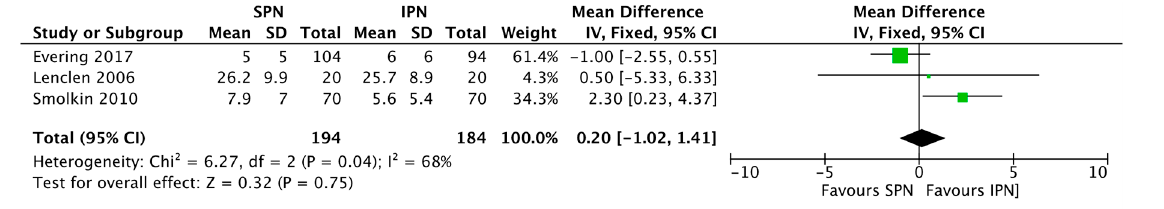
Figure 3. Forest plot on the effect of standardized parenteral nutrition (SPN) vs. individualized par- enteral nutrition (IPN) on mortality, necrotizing enterocolitis (NEC) incidence, and sepsis incidence. Blue squares represent individual studies, diamonds represent subgroup analyses.